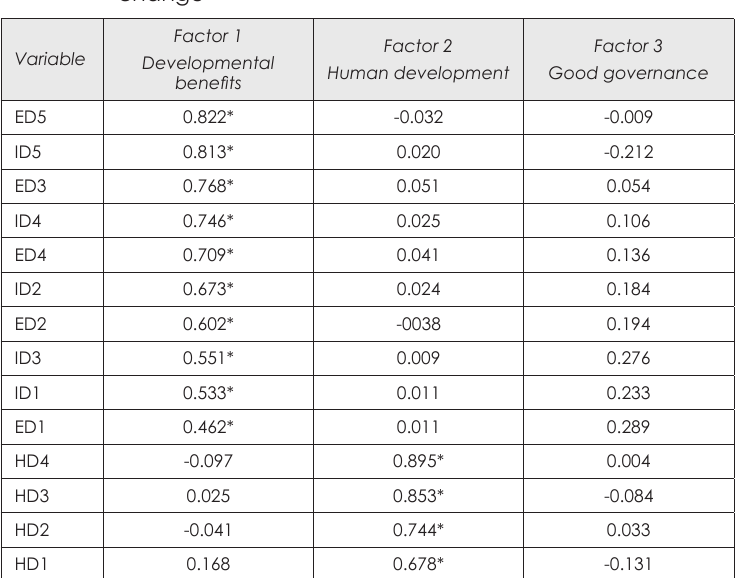
Rotated factor loadings: Sub-model – Transformational